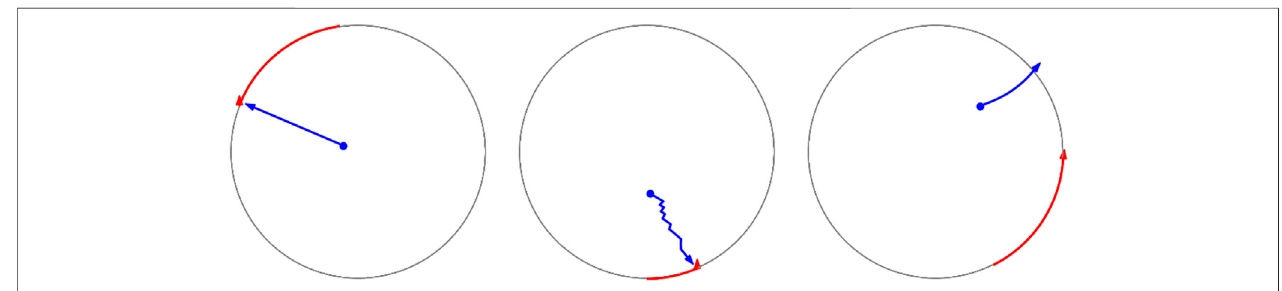
FIGURE 7 | Trajectories of sheep. (A) From left to right, each represents the trajectory of sheep from the baseline models 1 and 2 and the DRL model. (B) Blue curves are the trajectories of sheep, while the red ones are those of dogs.